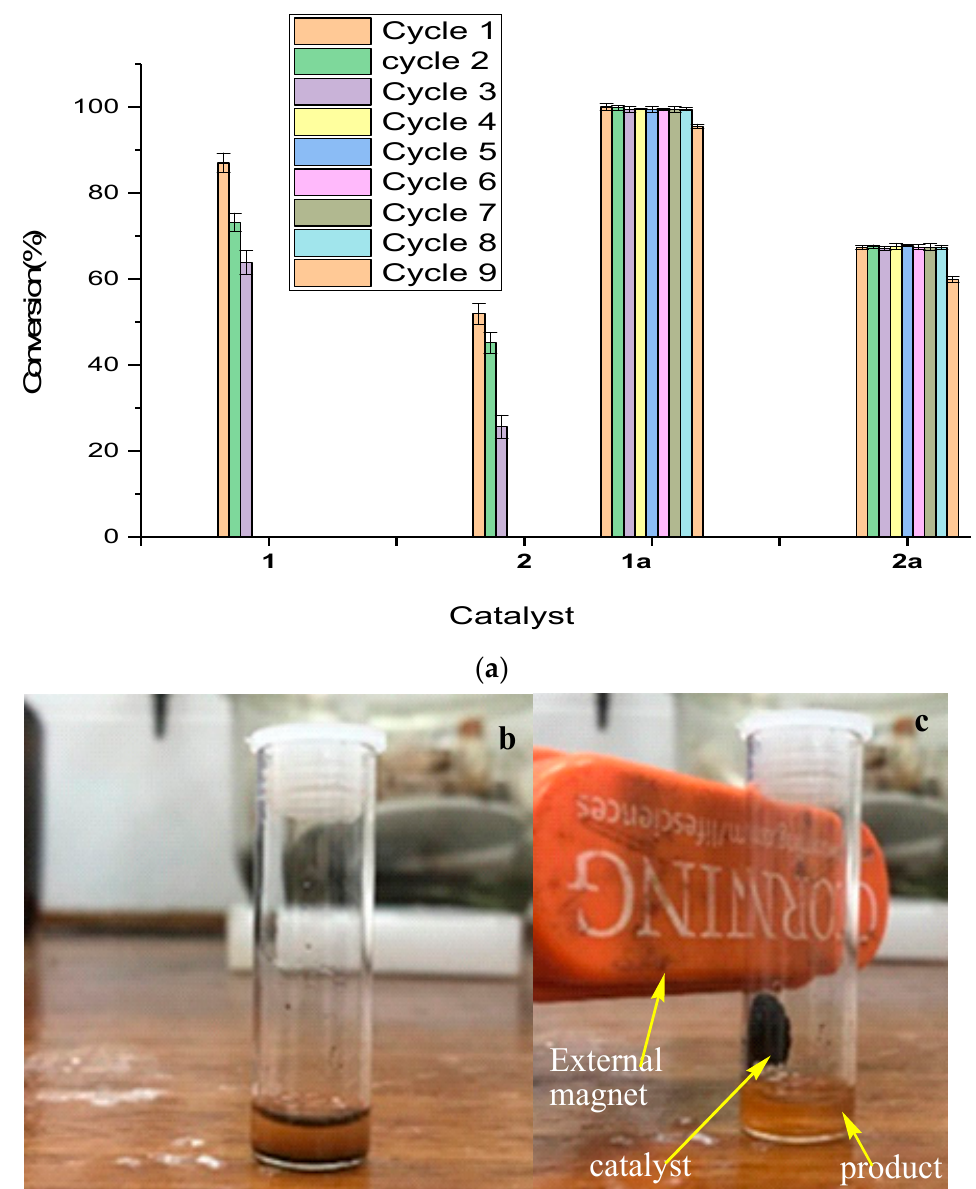
Figure 7. Recyclability studies using pre-catalyst C1 and C2 (labelled 1 & 2 ), Fe 3 O 4 @C2 ( 1a ) and Fe 3 O 4 @C1 ( 2a ). Reaction conditions: For pre-catalyst C1 and C2 : CAL (20 mmol), (catalyst:0.1 mol% for 1 & 2 and 0.8 mol% for Fe 3 O 4 @C2 and Fe 3 O 4 @C1 (formic acid 40 mmol, base 20 mmol),120 °C, 24 h Conversions estimated by Gas chromatography. ( a ) shows the maximum number of cycles the homogeneous catalyses before deactivation while ( b , c ) shows the isolation of the spent catalyst from the reaction mixture.